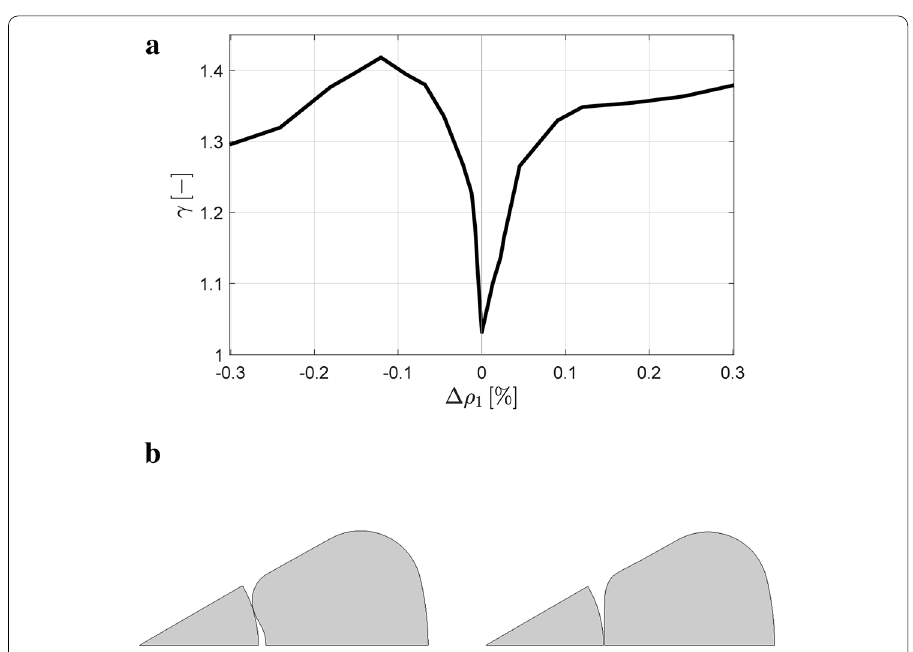
Fig. 14 Influence of a perturbation of the geometrical parameter ρ 1 . Below the plot, the corresponding resulting cross sections are shown. The change of (cid:7)ρ 1 has been scaled for visualization purposes, on the left for negative (cid:7)ρ 1 , on the right for positive variations